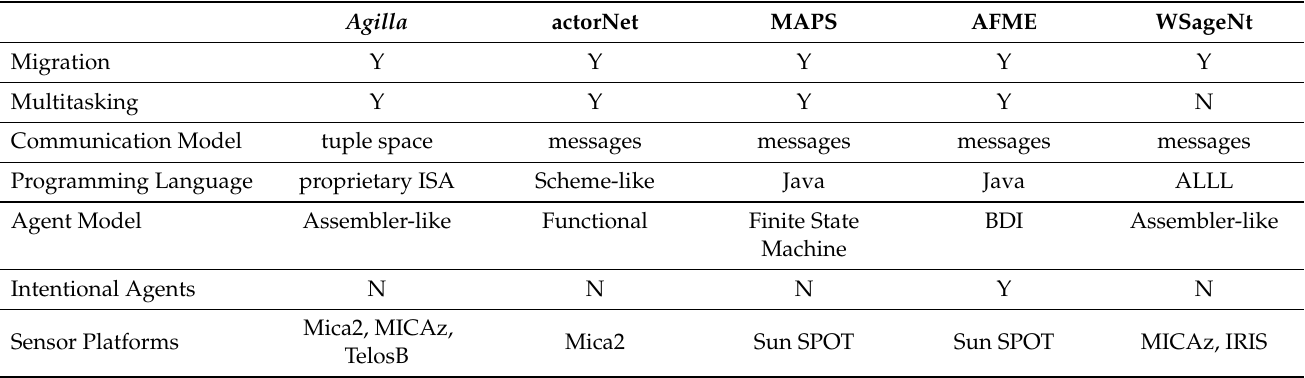
Table 2. Agent-based middleware (MW) comparison.